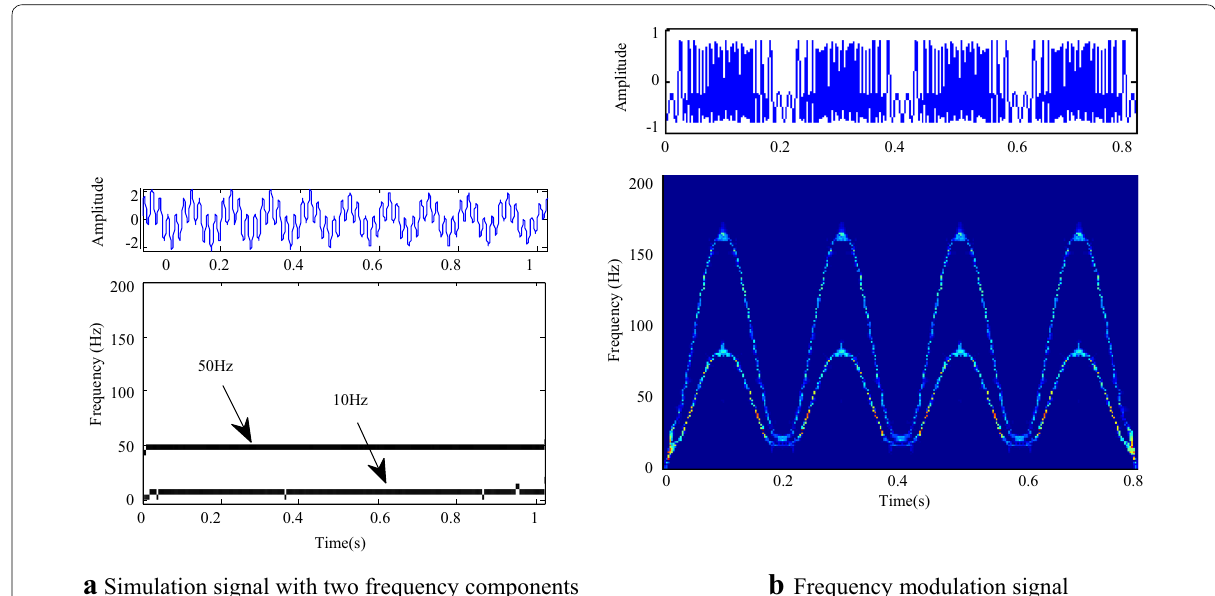
Figure 15 Hilbert time-frequency diagrams of typical